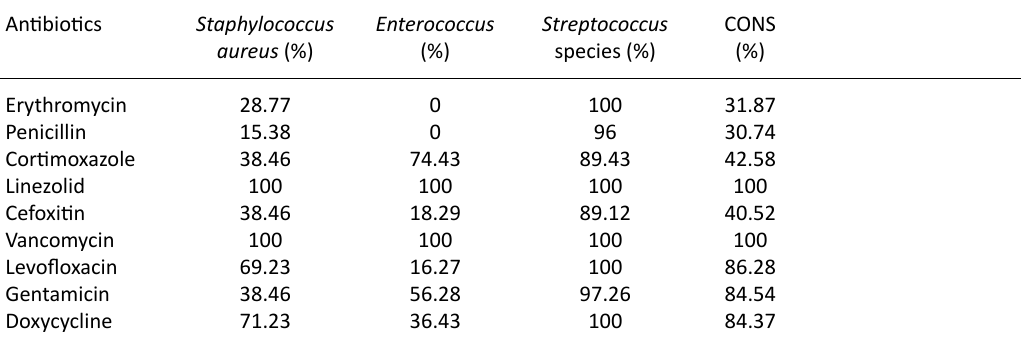
Table 3. Antibiotic sensitively pattern of Gram positive organism Antibiotics Staphylococcus Enterococcus Streptococcus